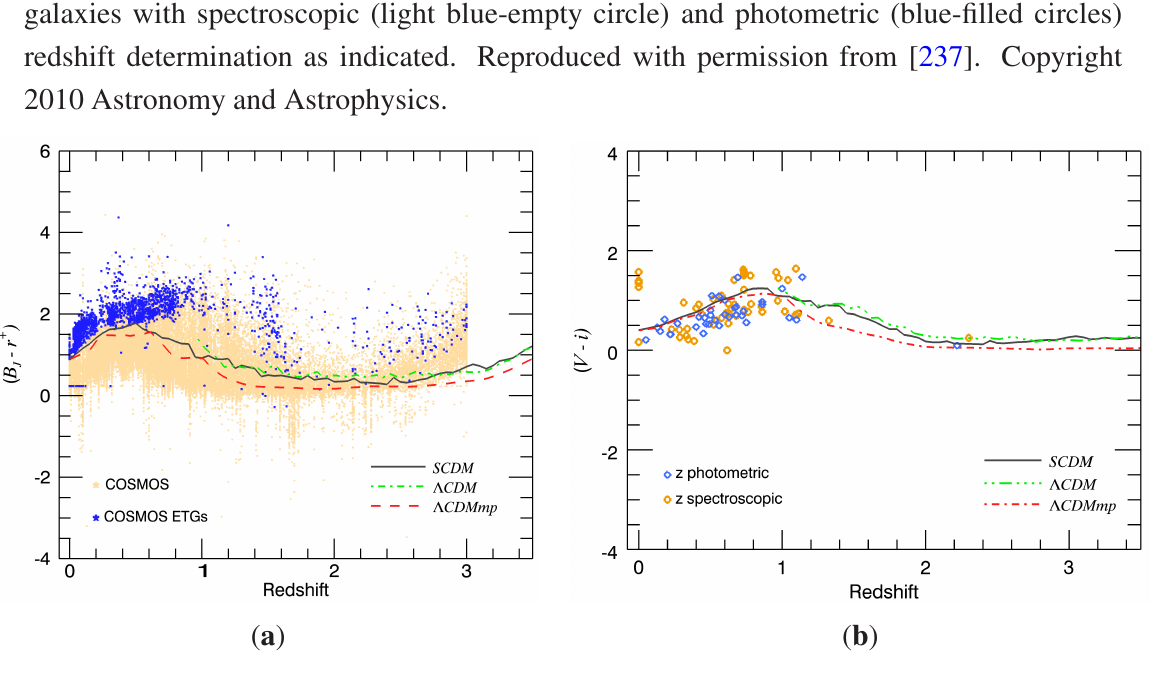
r + ) color of the COSMOS J − < 1 . 1 phot